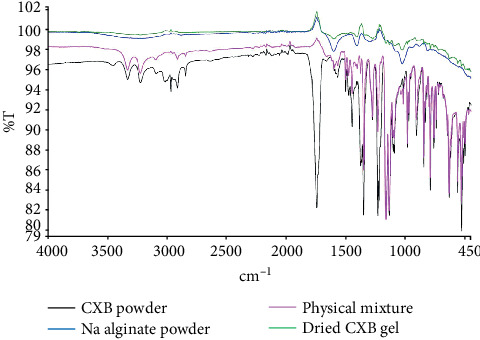
FTIR spectra of CXB powder, SA powder, physical mixture, and CXB-dried gel. Color legend indicates the following: black: CXB; blue: SA; pink: CXB/SA physical mixture; and green: CXB-dried gel.